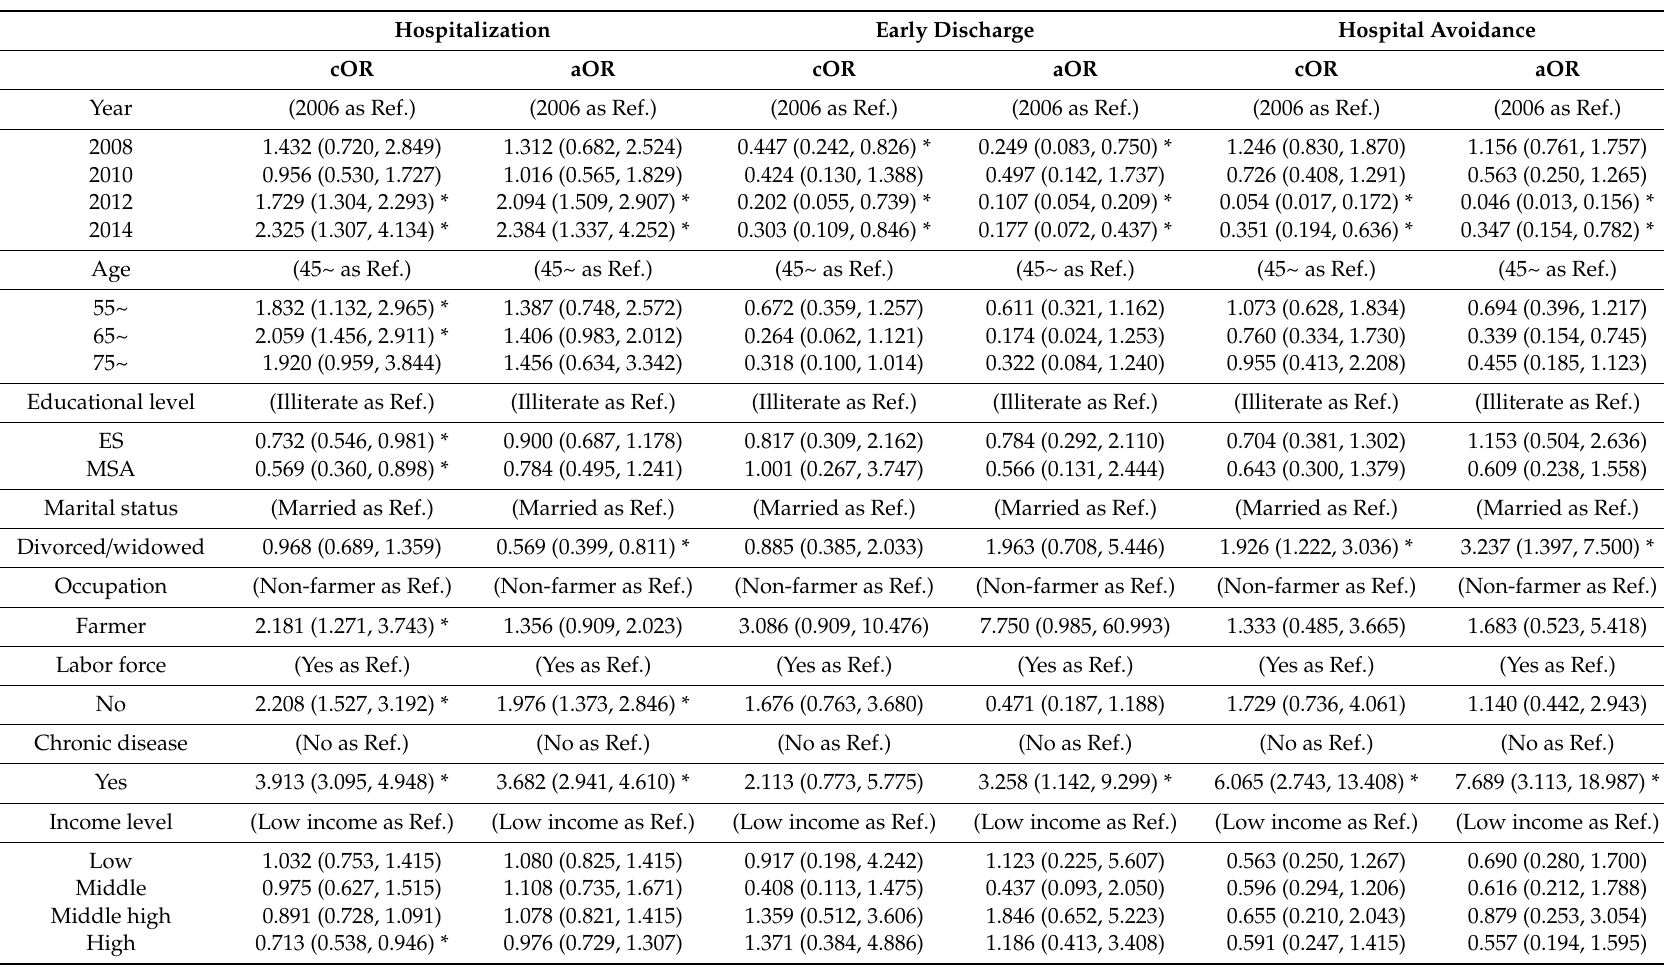
Table 4. Analysis three indexes of inpatient service utilization using complex sampling logistic regression among mid-aged and older females (%, 95% CI).